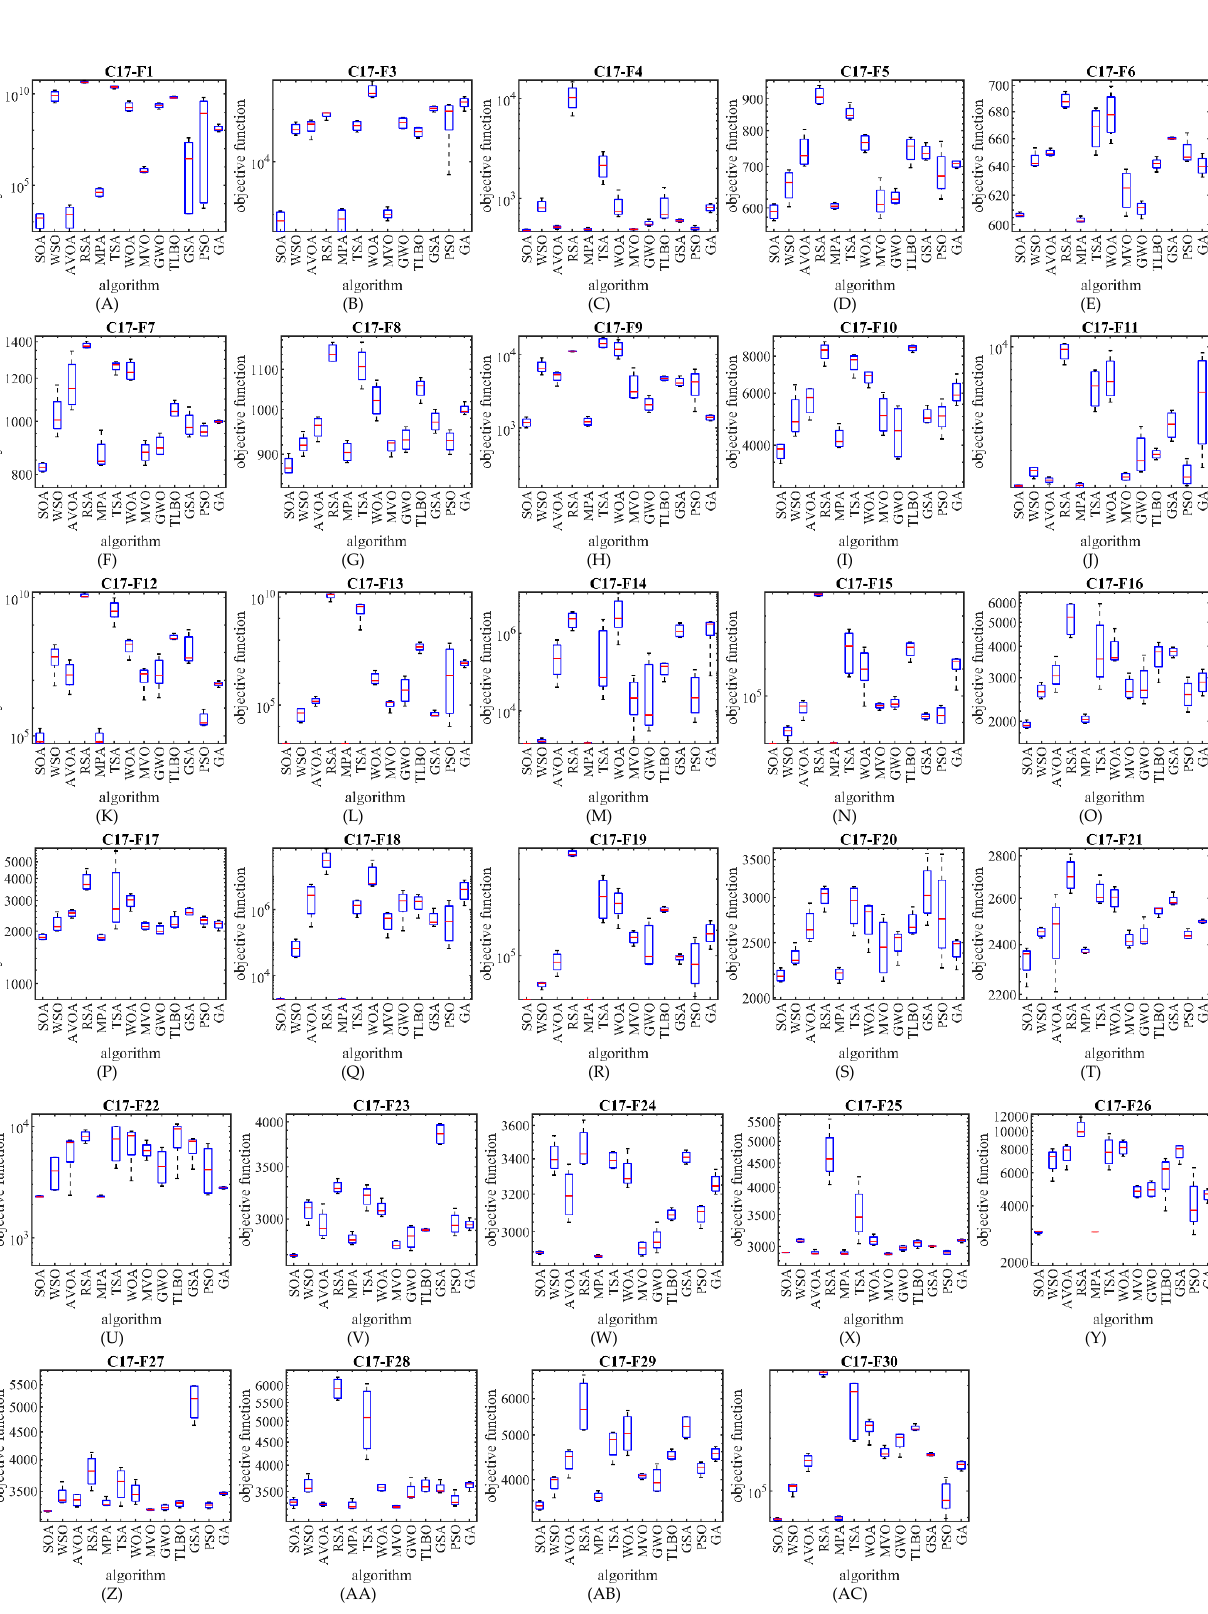
Figure 3. Boxplot diagram of SOA and competitor algorithms performances on the CEC 2017 test suite (for the dimension 𝑑 = 30 ).